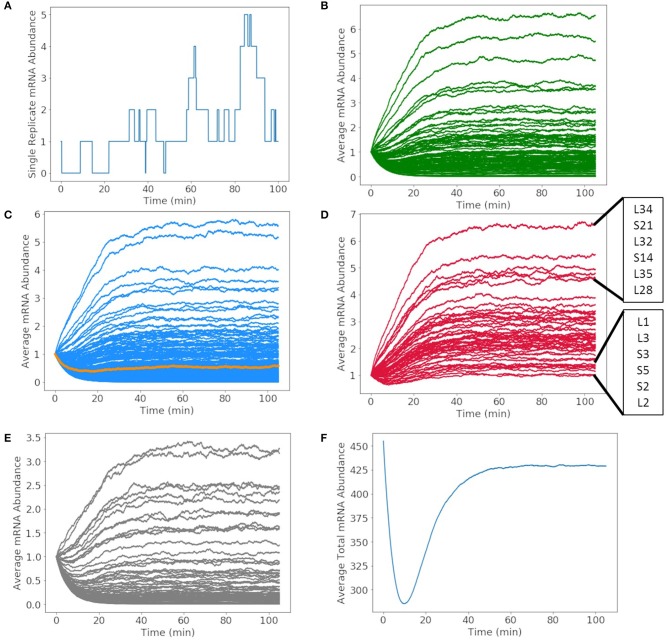
Abundances of mRNA and tRNA transcribed in a 105 min cell cycle. (A) A single replicate from the stochastic simulation of the mRNA abundance for glucose-6-phosphate isomerase shows fluctuations in the average integer abundance of messengers. Fluctuations arise from competing rates of formation, degradation, and replication. The average mRNA abundances of mRNA coding for (B) metabolic proteins, (C) genetic information processing, DnaA (orange), and cell division proteins, (D) ribosomal proteins, and (E) proteins of unclear function all have average abundances between zero and seven. (F) The total number of all messengers during a cell cycle averaged over 1,000 replicates shows that typically there are 300–450 messengers present in the cell at any time.